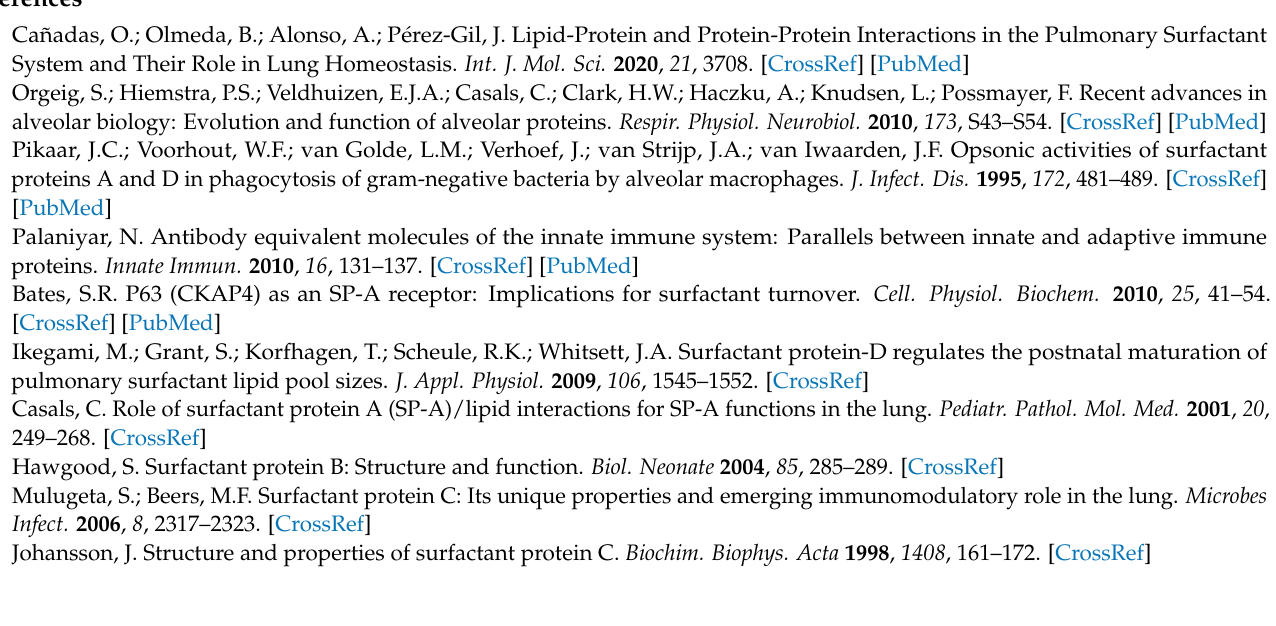
Wallis test, Table S4: Post hoc tests—Tukey’s and Dunnett’s tests for ST, SP-G, SP-C, cell count, lactate, glucose and total CSF protein, Table S5: Post hoc tests—Tukey’s and Dunnett’s tests for SP-A, SP-B and SP-D, Table S6: Spearman rho test for correlations between age, and ST and SPs in the control